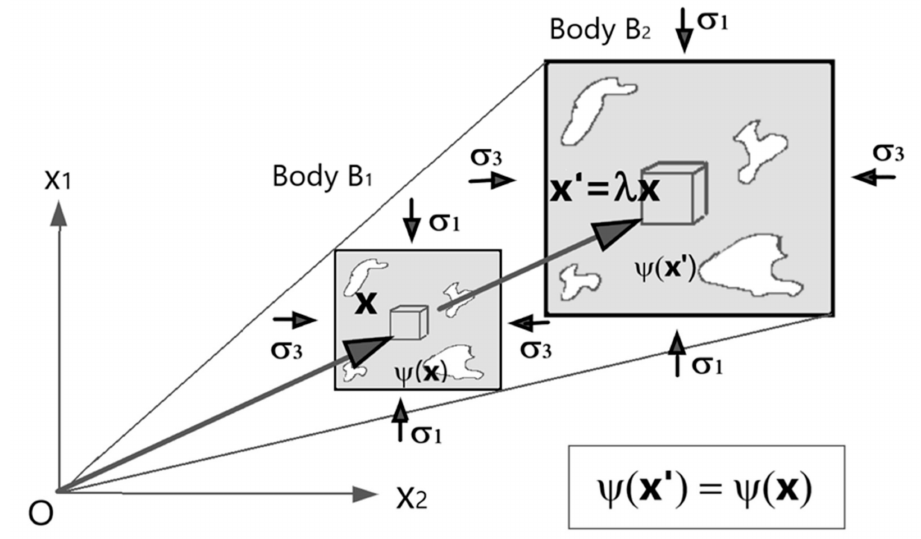
Figure 4. Two geometrically similar bodies B1 and B2, under the same external stress system, show similar local stress fields, i.e., within such bodies the same local stress tensor is associated to corresponding points.